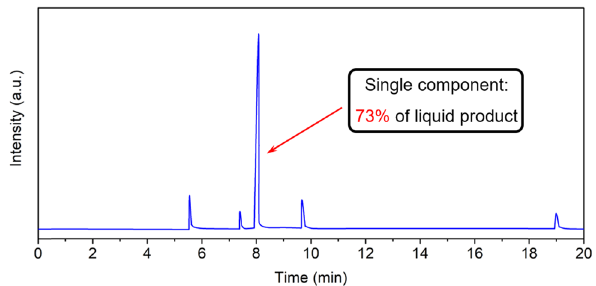
Figure 3: Gas chromatography spectra of liquid product from pyro - lysis of